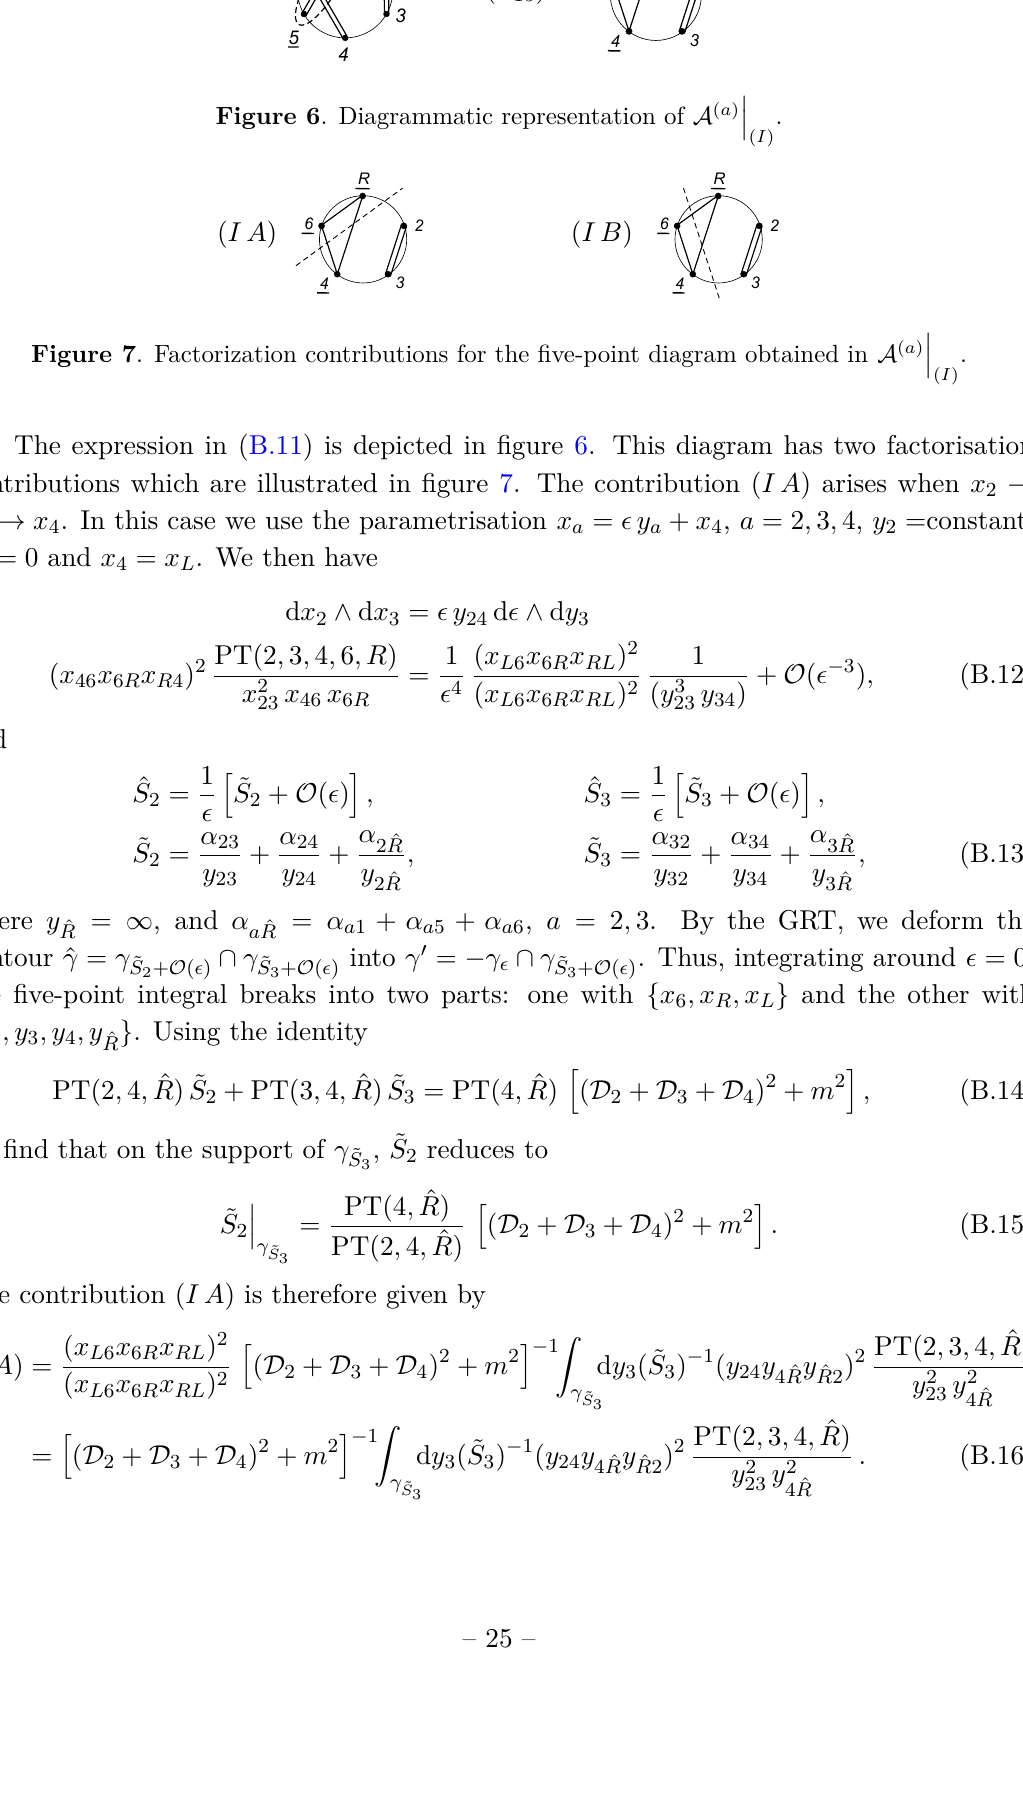
Figure 6 . Diagrammatic representation of A ( a )